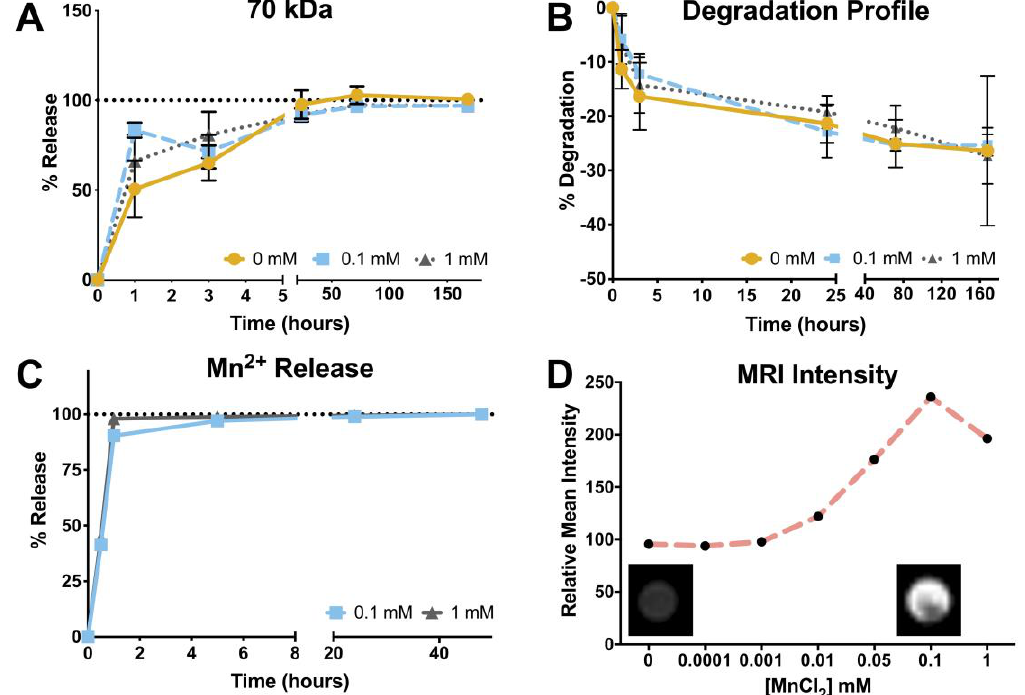
Figure 2. Release and degradation profiles of Mn-based GG-MA hydrogels. ( A ) Release profile of 70 kDa Dextran-FITC, from the hydrogel to surrounding aCSF; ( B ) degradation profile of Mn-based hydrogels along time; ( C ) time-dependent Mn 2+ release from the prepared hydrogels. Results presented as average ± SD, n = 5. ( D ) relative mean intensity of the magnetic resonance signal of T1-weighted imaging obtained with phantoms of GG-MA hydrogels supplemented with different concentrations of manganese ions (ex